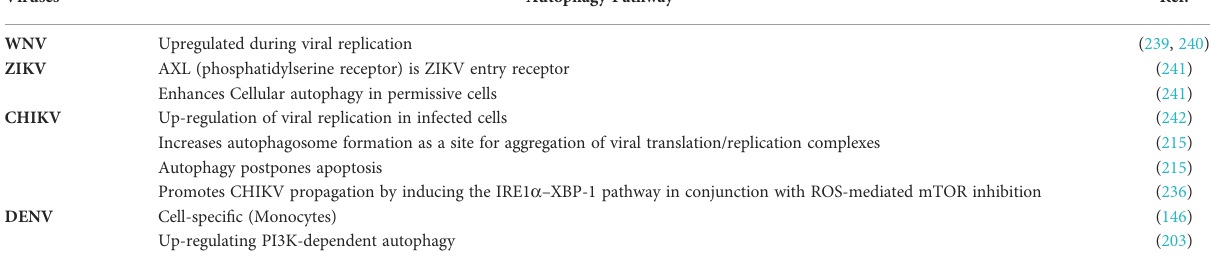
TABLE 7 Arboviruses and